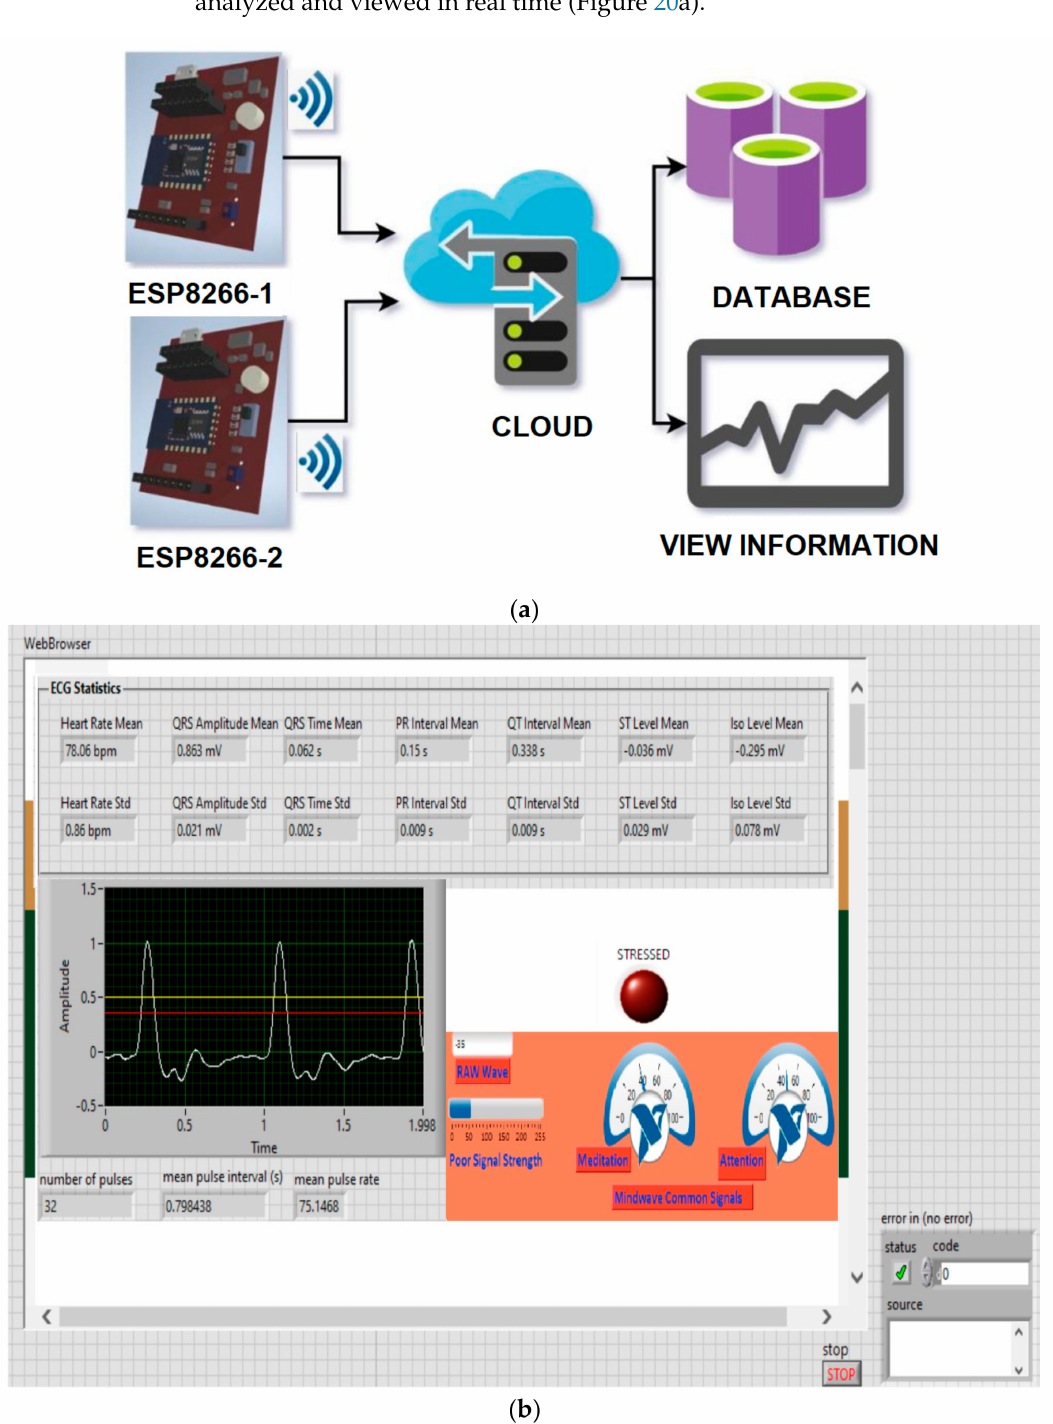
Figure 20. ( a ) IoT management system diagram for a sensor node; ( b ) view of the WEB page developed for data